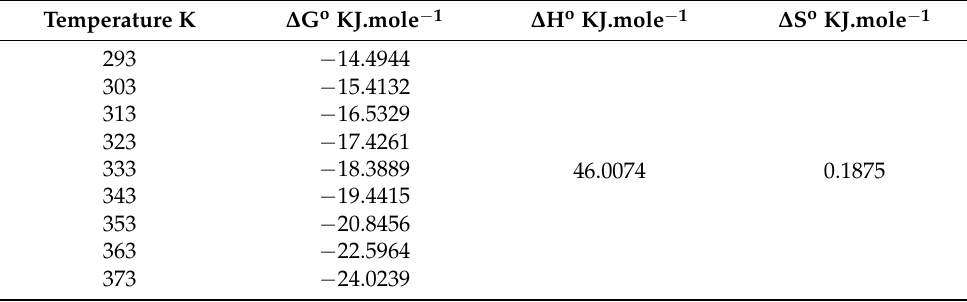
Table 3. Thermodynamic parameters for the adsorption of Cr(VI) on (MNPs/rGO/PMMA).